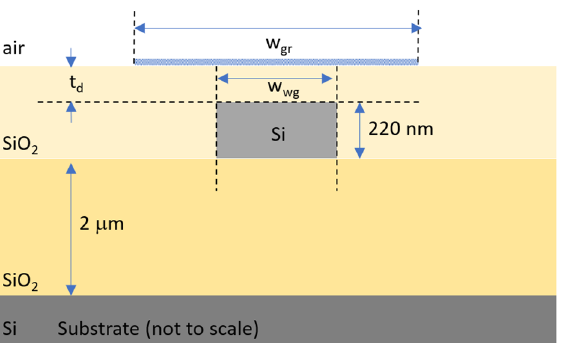
Figure 2. Cross-section of the graphene-on-silicon waveguide used in the 2D simulations to study polarization control.